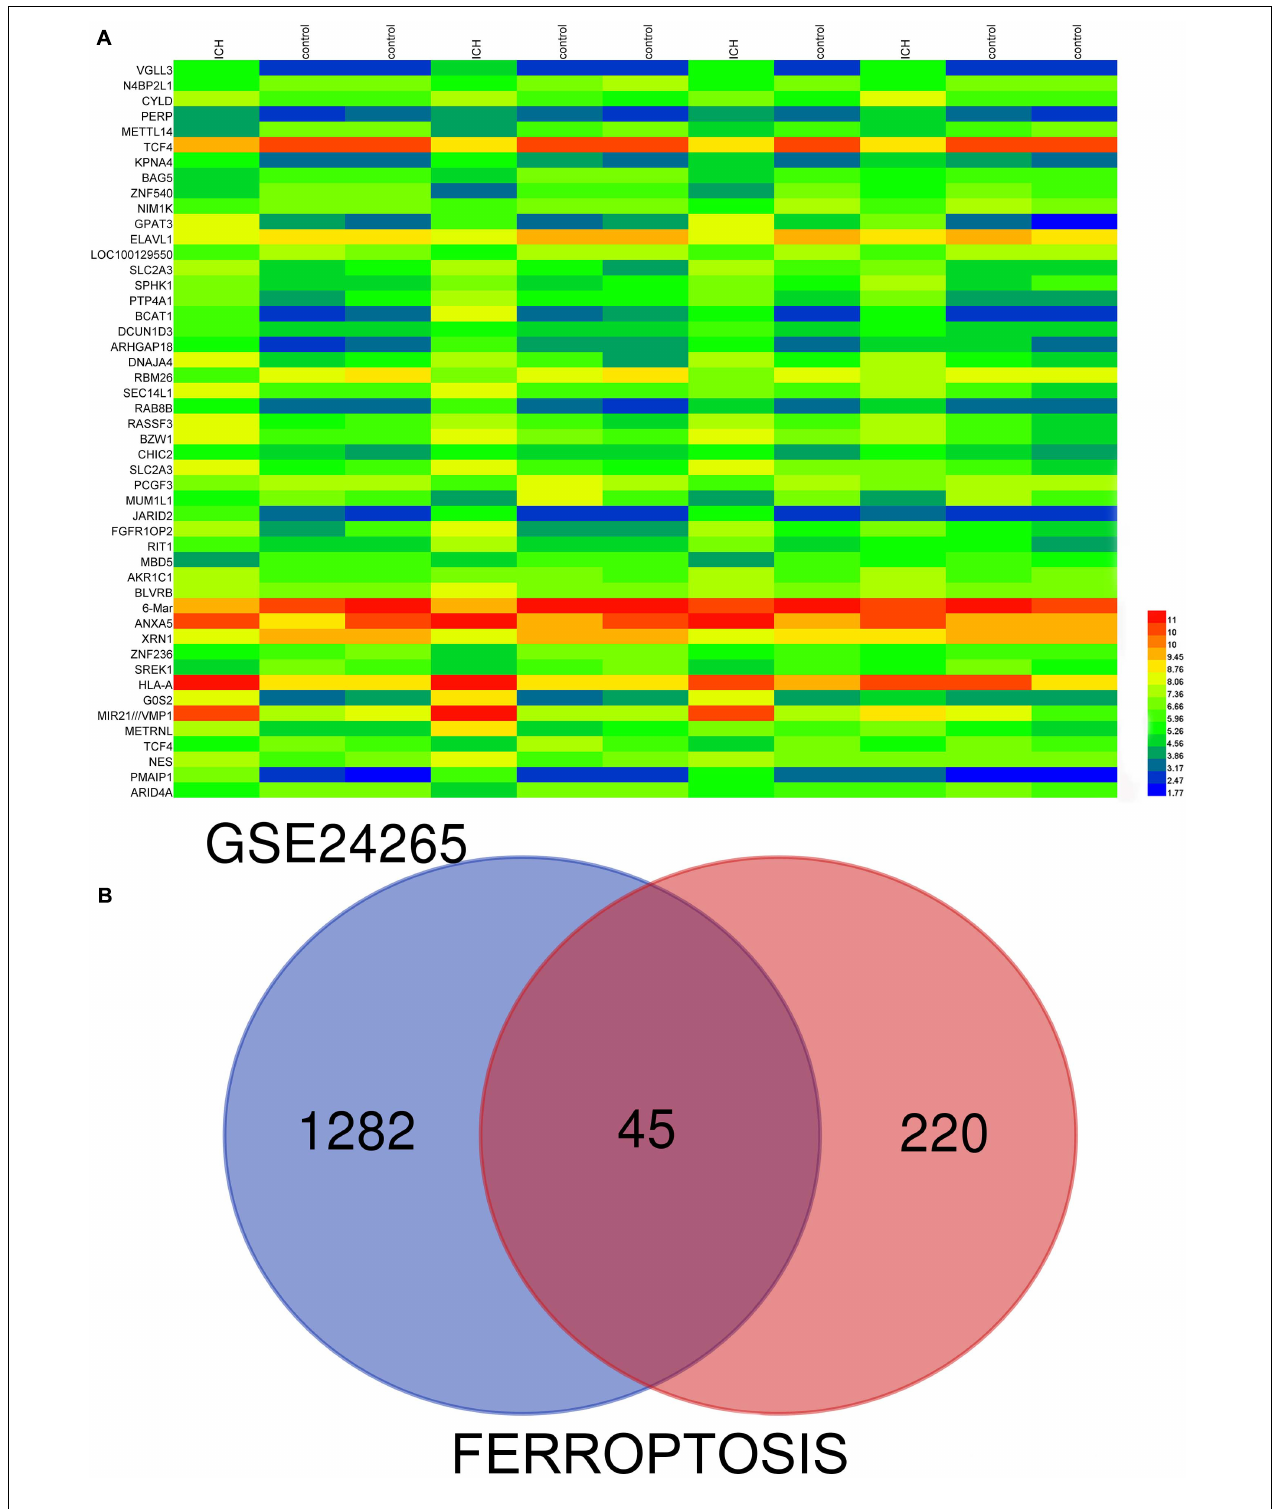
FIGURE 1 | (A) There were 1,327 differentially expressed genes (DEGs) in perihematomal tissue and normal tissues. The first 50 differentially expressed genes were shown in the heat map, with red representing significantly up-regulated genes and blue representing significantly down-regulated genes in the samples. (B) Venn diagram of ferroptosis differentially expressed genes. We intersected ferroptosis dataset with GSE24265 to identify ferroptosis DEGs.